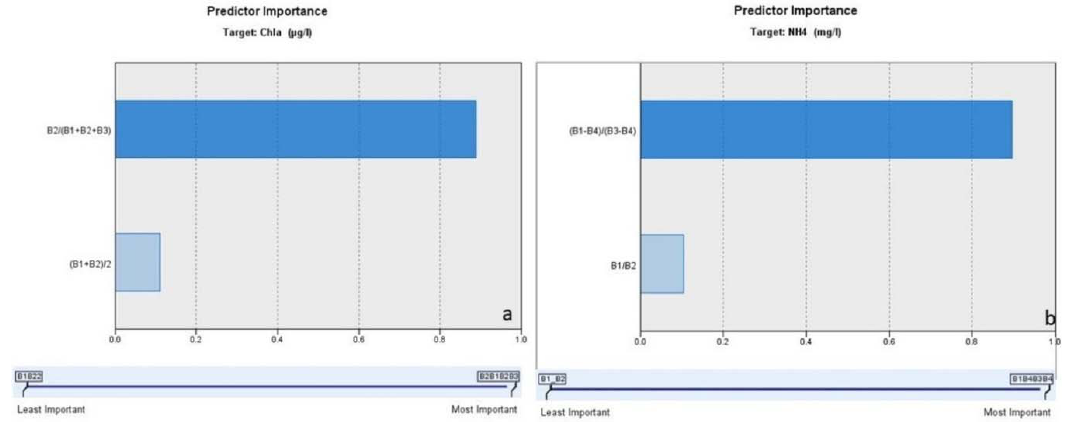
Figure 5. ( a ) Predictor importance charts indicating the optimal factors for the assessment of Chlorophyll ‐ a and ( b ) Ammonium concentrations. Table 10. Statistical summary and description of final water quality parameters’ models.